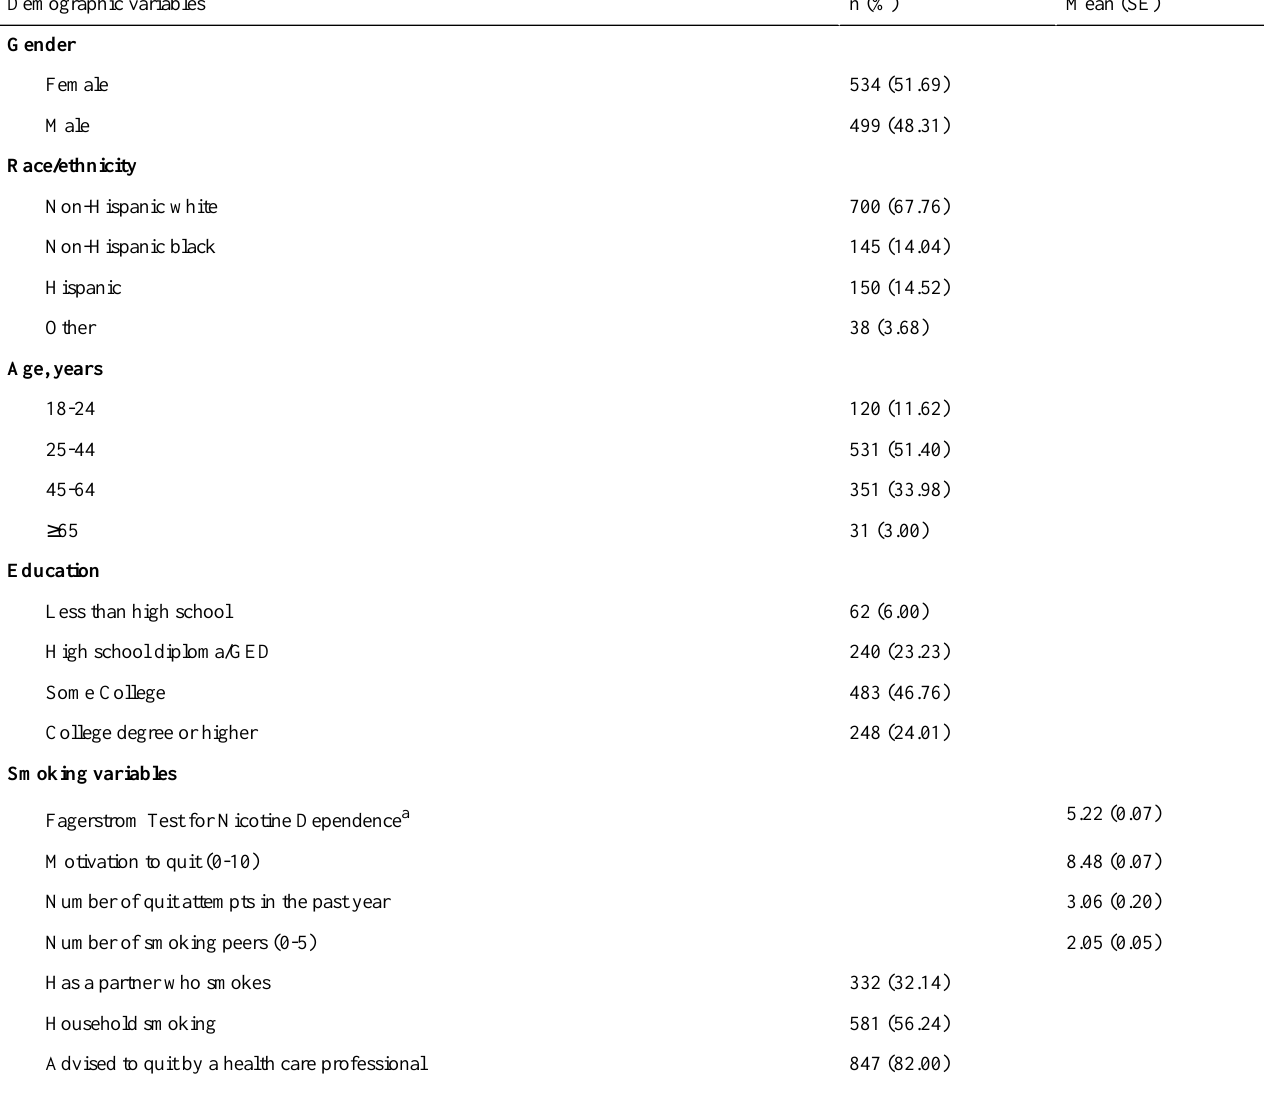
Table 1. Baseline characteristics of study participants using the BecomeAnEX.org smoking cessation website